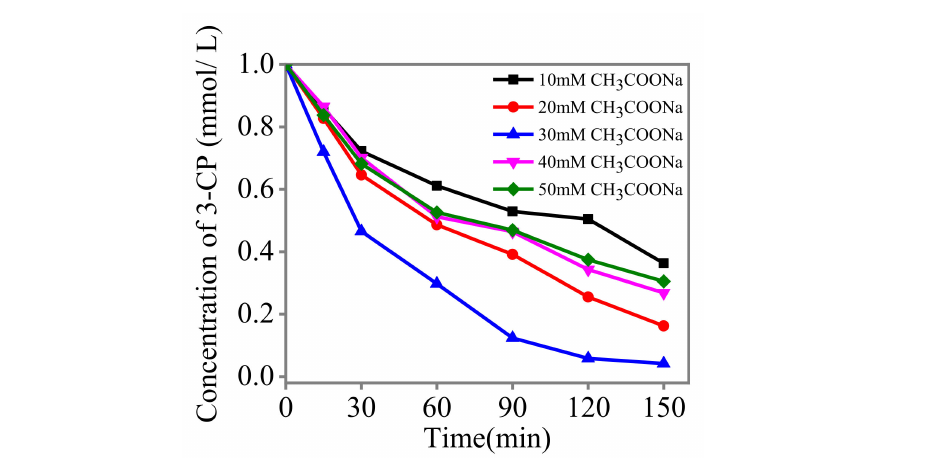
Figure 11. Effect of concentrations of CH 3 COONa on variation of the 3-CP concentration.